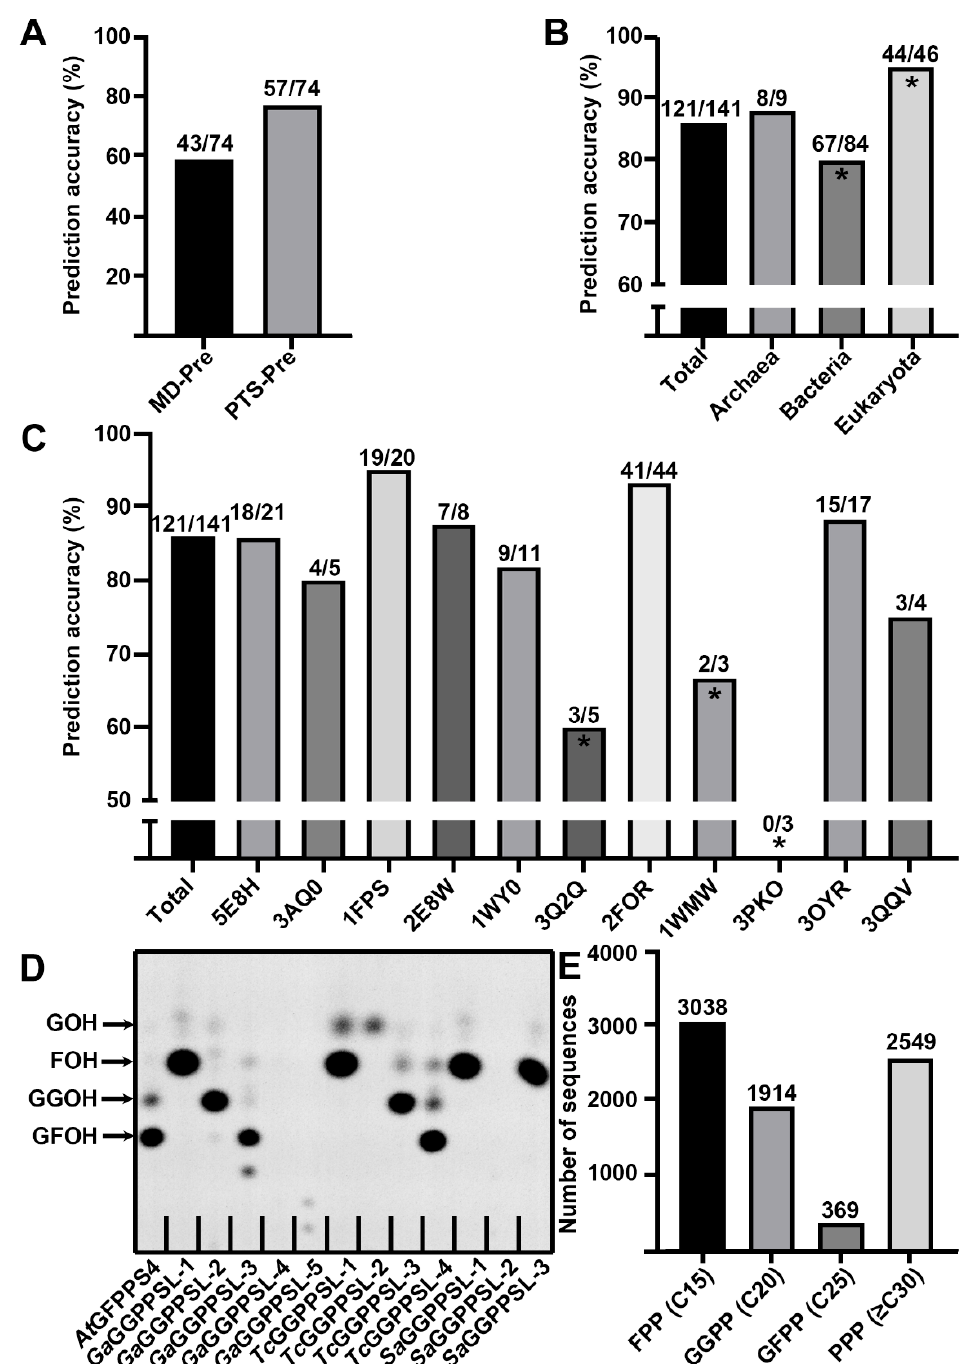
Figure 3. The prediction and verification results of PTS-Pre. ( A ) Comparison of prediction accuracies between MD-Pre and PTS-Pre over 74 testing sequences. ( B ) Comparison of prediction accuracies across three life kingdoms. Panels with comparatively higher or lower accuracy are marked with asterisks. ( C ) Comparison of prediction accuracies using different searching templates. Panels with comparatively higher or lower accuracy are marked with asterisks. In ( A – C ), the quantities of correctly predicted and total cases are labeled on the top of each panel. ( D ) In vitro activity of predicted trans- PTs from Streptomyces azureus , Tolypothrix campylonemoides , and Gossypium arboreum . All predicted trans- PTs were characterized using DMAPP and [1–14C]-IPP as co-substrates; the products were analyzed by TLC. AtGFPPS4 was used as a positive control. ( E ) The distribution of predicted products in the trans- PTs family.